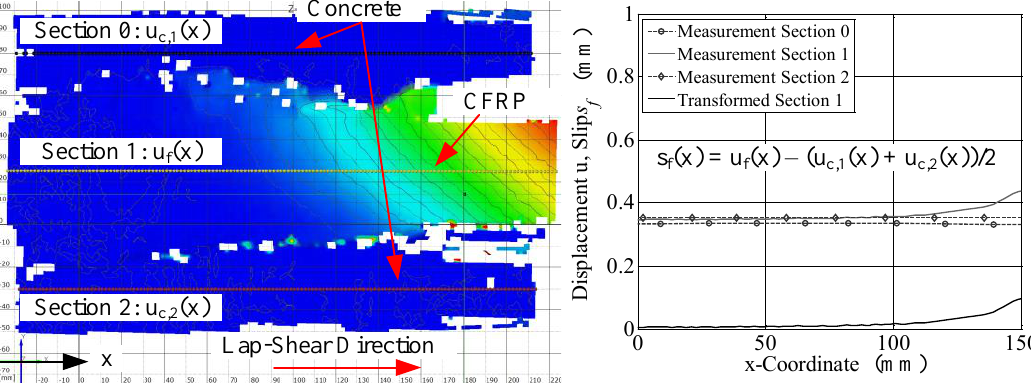
Figure 8. Left : Output of X-displacements (lap-shear loading direction) of a sample obtained from the test setup presented in Figures 6 and 7, and the defined sections along the concrete and CFRP strip; right : displacements and obtained slip profile along the bond length, along with the formulation for slip